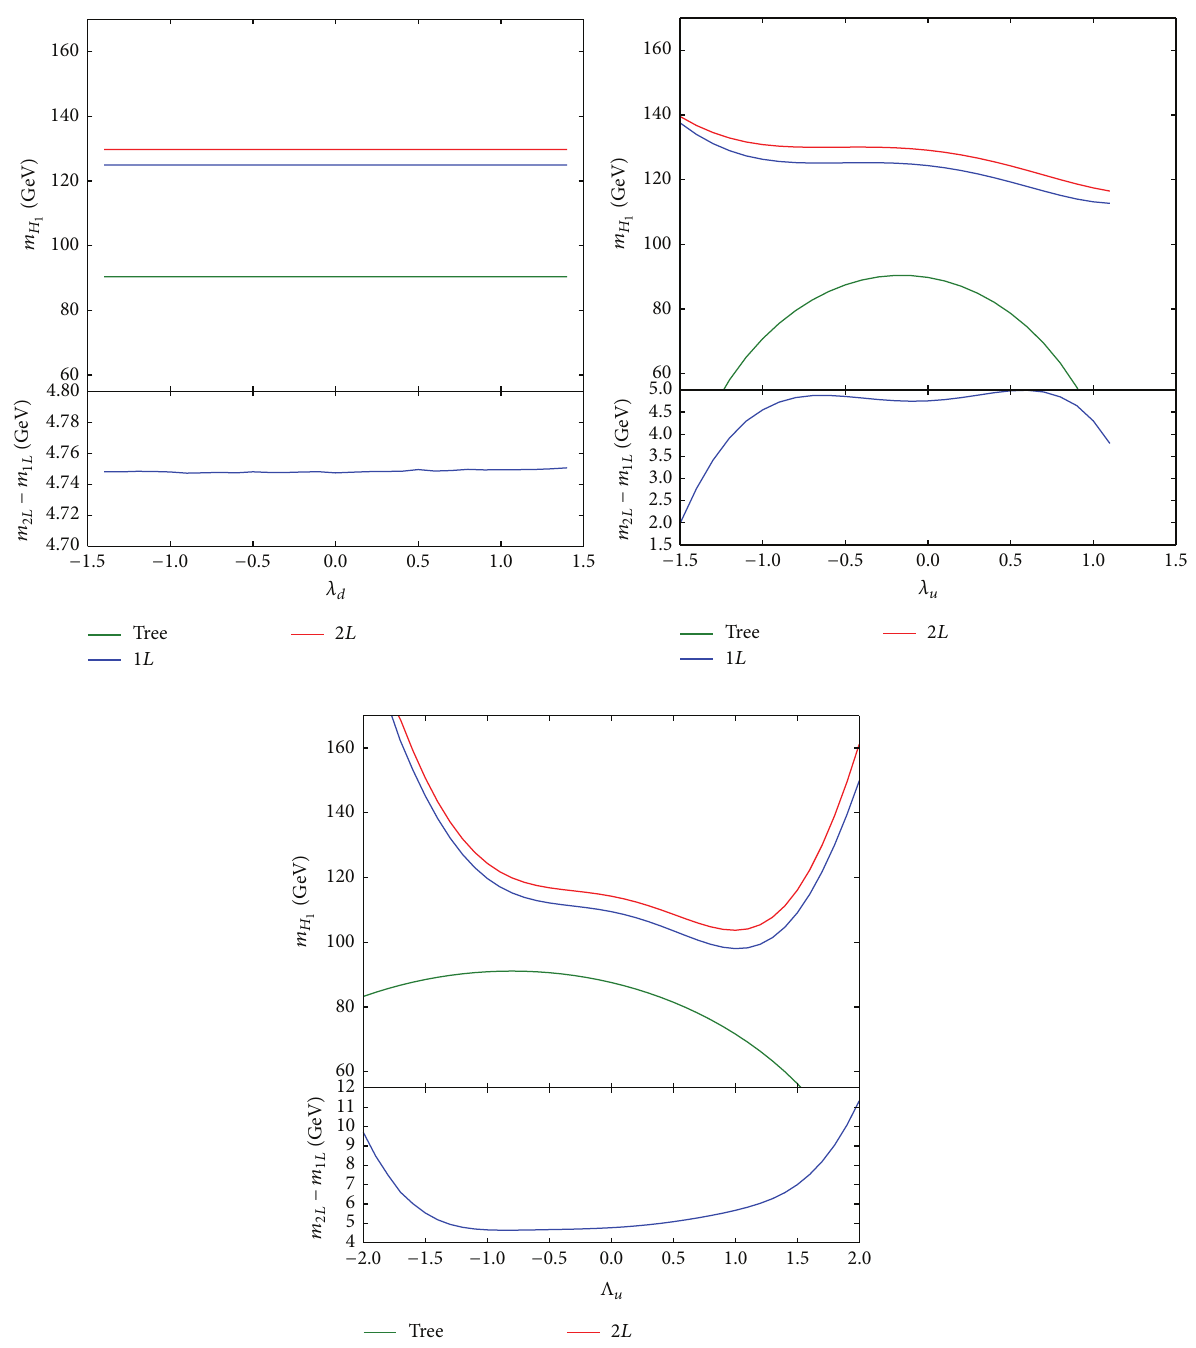
Figure 2: As in Figure 1, but for benchmark point BMP3 with tan 𝛽 = 40 (see Table 2).